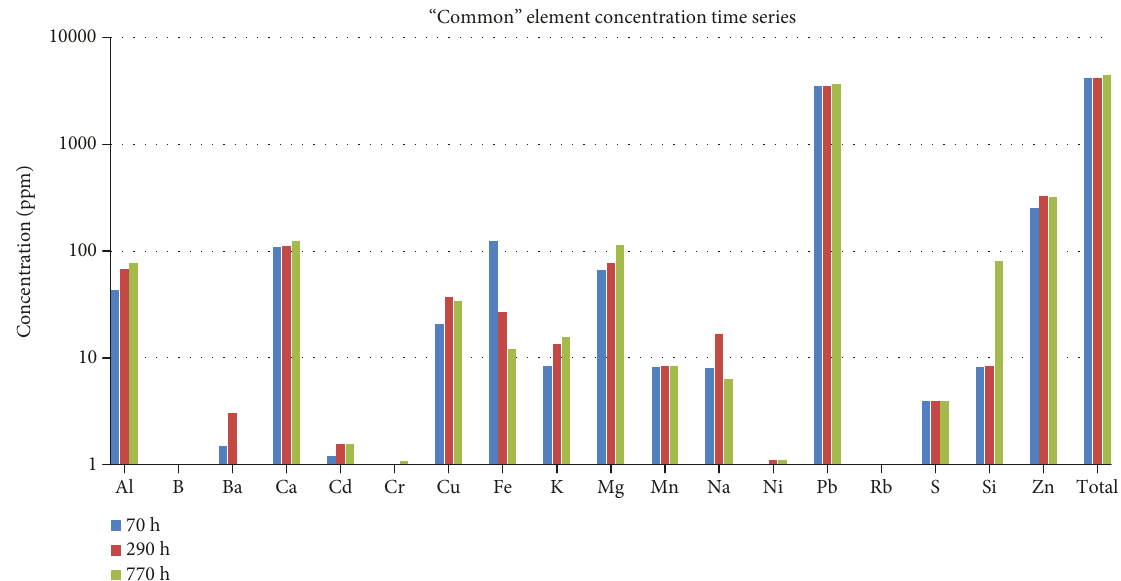
Figure 19: The kinetics of elemental composition over time in leachates from HTLMix sample reacted with 0.13M mineral acid at 100 ° C temperature under 200bar pressure in the batch reactor after 70, 290 and 770 hours, respectively.